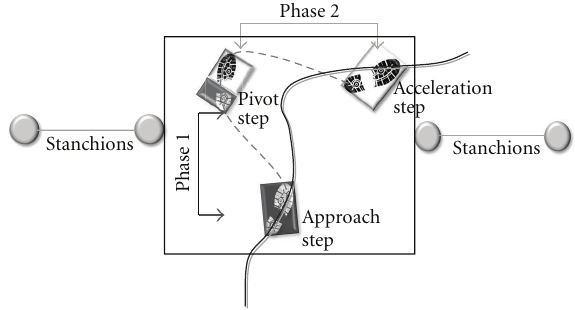
Figure 2: Schematic representation of the COP and the eCOM trajectories during the step turn. Solid line: eCOM trajectory; dashed gray line: COP trajectory; Phase 1: from approach step to pivot step; Phase 2: from pivot step to acceleration